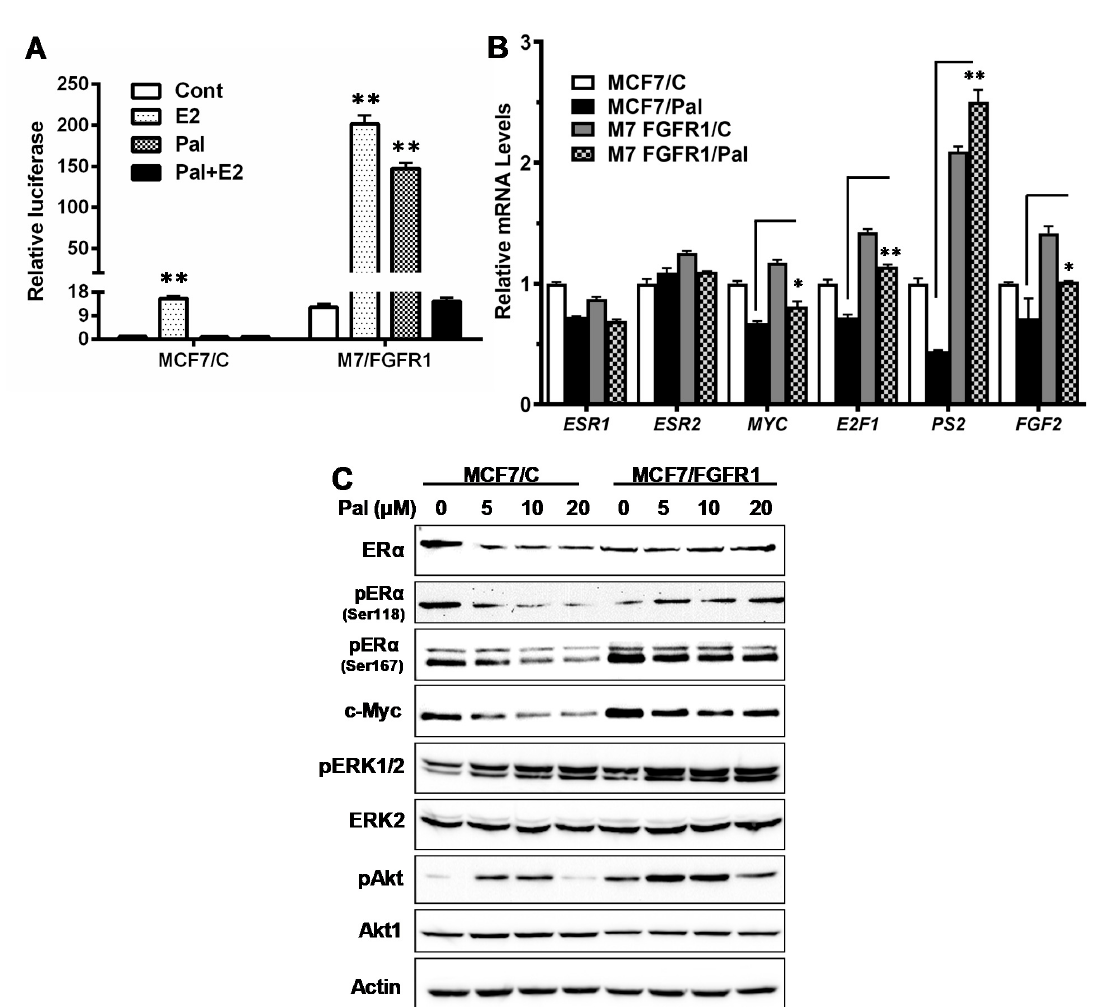
Figure 4. Effect of FGFR1 overexpression on ER-mediated transcription and ER α phosphorylation. ( A ) Luciferase reporter assay of ERE-mediated transcription in MCF-7/C and MCF-7/FGFR1 cells. The cells were transfected with plasmids encoding an ERE-firefly luciferase and control Renilla luciferase, followed by treatment with E2 (10 nM) and palbociclib (5 μ M), alone or in combination, for 24 h. The relative luciferase activity of each cell line is normalized and compared to the control of MCF-7/C cells. ( B ) qPCR analysis of mRNA levels of pertinent ER target genes ( ESR1/ER α , ESR2/ER β , MYC, E2F1, PS2, and FGF2 ) in MCF-7/C and MCF-7/FGFR1 cells treated with palbociclib (0, 5 μ M) for 24 h. ( C ) Western blot detection of ER α phosphorylation in context with c-Myc expression and the phosphorylation of Akt and ERK1/2. MCF-7/C and MCF-7/FGFR1 cells were treated with palbociclib, at the indicated concentrations, for 48 h, followed by Western blot analysis of specified markers. Values in ( A , B ) based on triplicate samples were analyzed with Student’s t -test (* p < 0.05; ** p < 0.01).